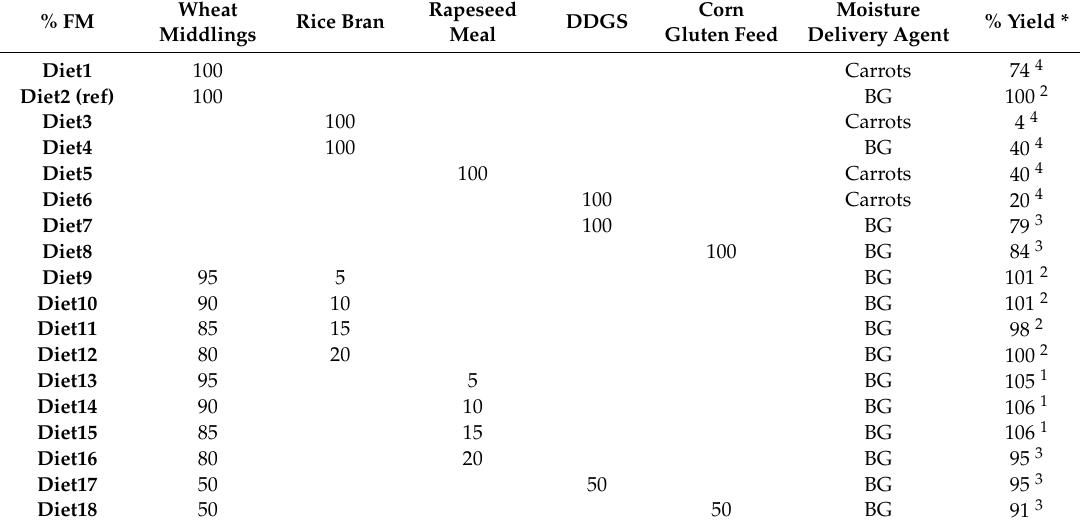
Table 1. Overview of all tested diets with the inclusion percentage of side-streams and a summary of the rearing